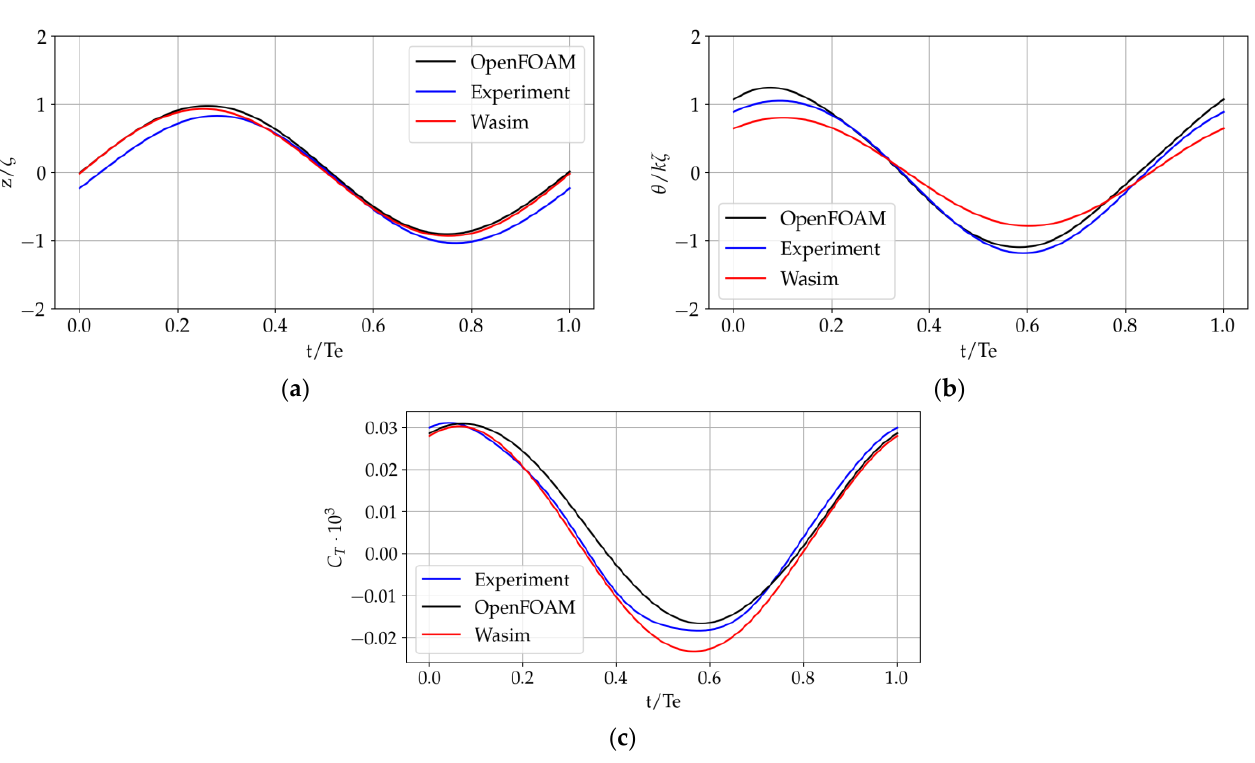
Figure 25. Time histories for case C4: nondimensional ( a ) heave, ( b ) pitch, ( c ) total resistance for the KRISO containership.